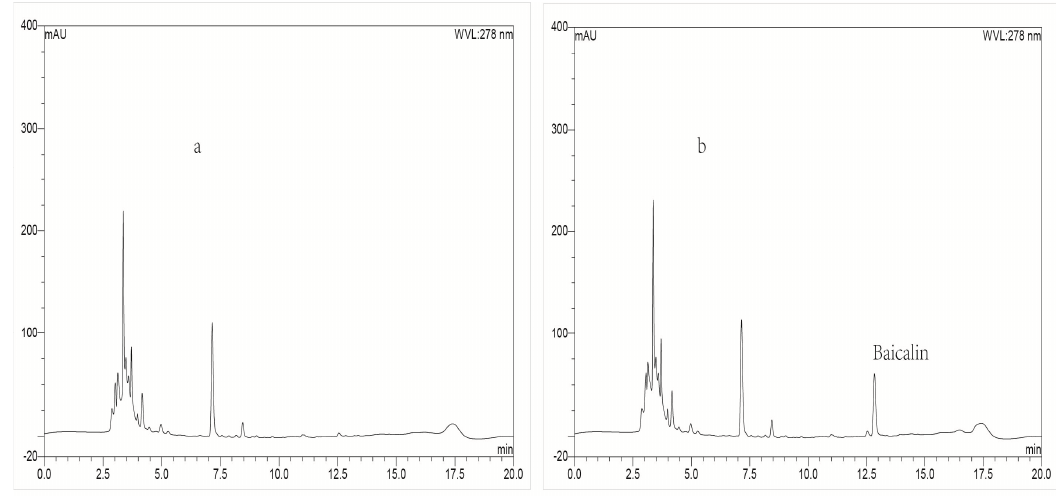
Figure 2. Cont. Figure 2.